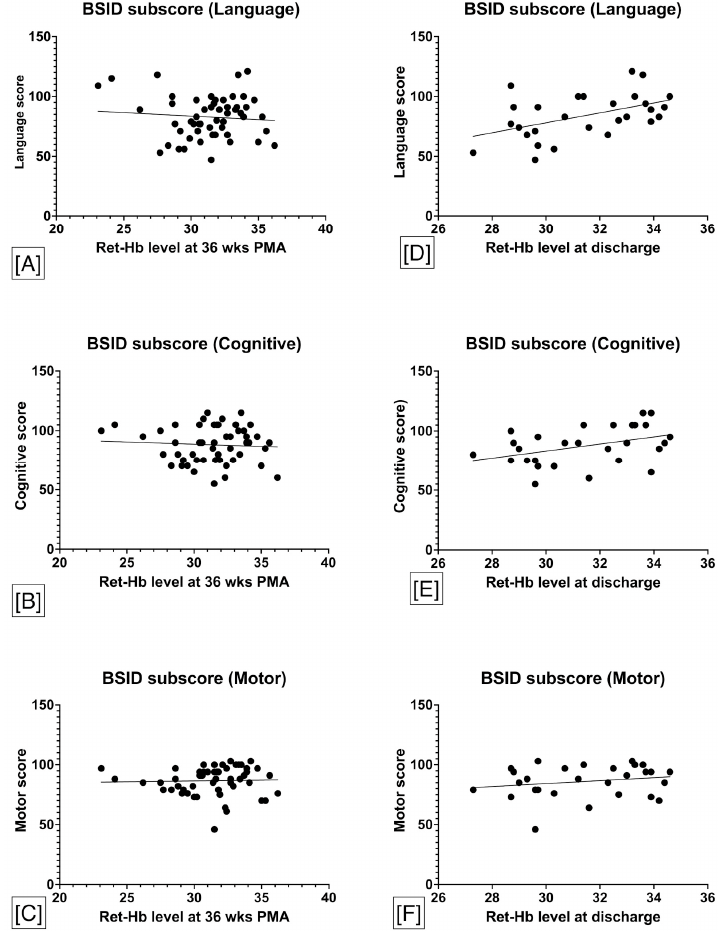
Figure 3. Association between Ret-Hb levels and BSID subscores in each domain at 18–24 months. There was no significant association between Ret-Hb levels at 4 weeks postnatal age and 36 weeks PMA with BSID-III subscore in cognitive ( B ), motor ( C ), and language ( A ) domains. However, Ret-Hb levels at discharge had a significant correlation with BSID-III subscores on language ( D ) domain and cognitive ( E ) domain, but not in motor ( F ) domain. Abbreviations: Ret-Hb, Reticulocyte hemoglobin; PMA, postmenstrual age; BSID, Bayley Score for infant development.